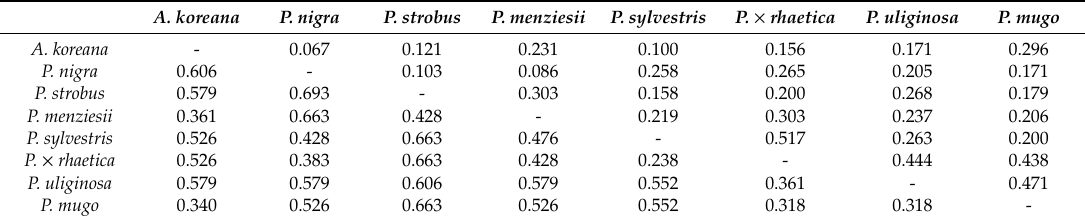
Table 2. Nei’s genetic distance (GD; below diagonal) and Jaccard similarity coe ffi cient (JS; above diagonal) based on the STP profiles